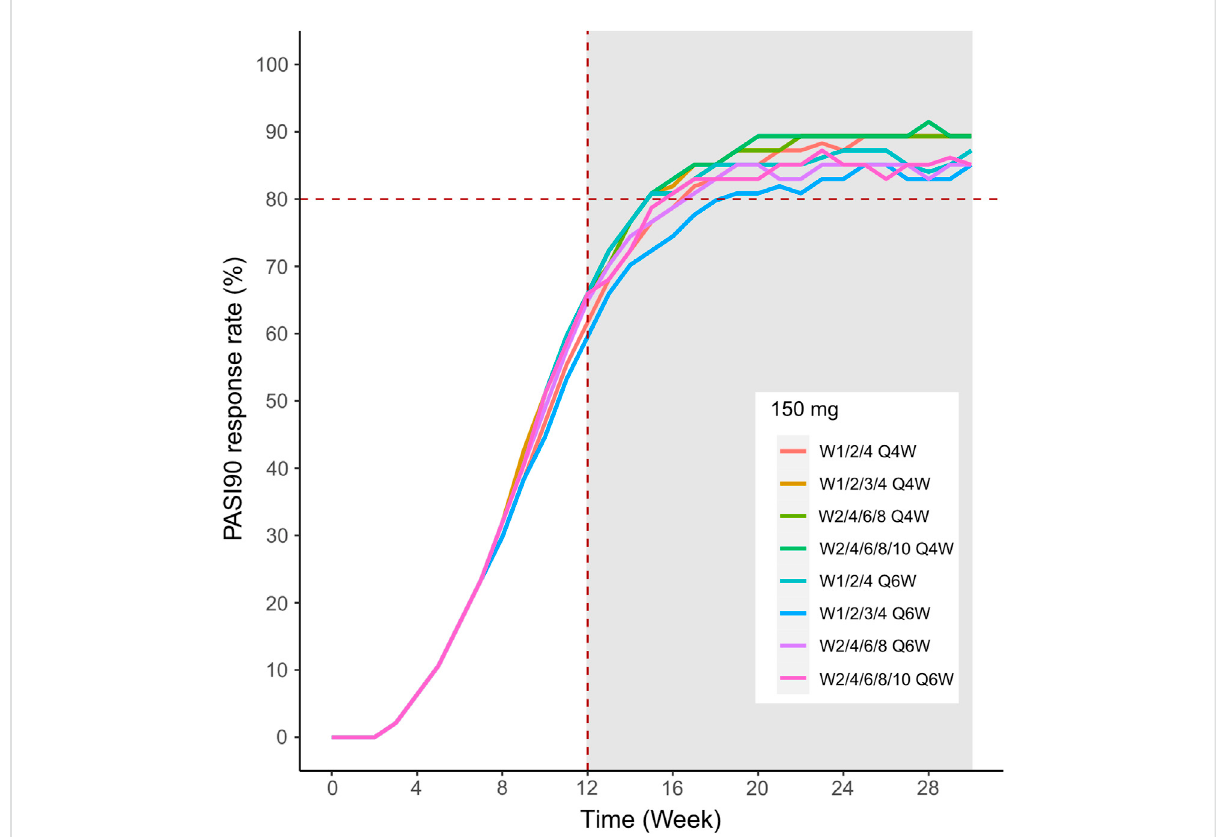
FIGURE 11 Simulated median PASI75 and PASI90 response rates under different dose regimens using the fi nal population PK/PD model. The PASI90 response rate of 300 mg ineight dosing regimens. Different colors of lines represent themedian response rate of different dosing